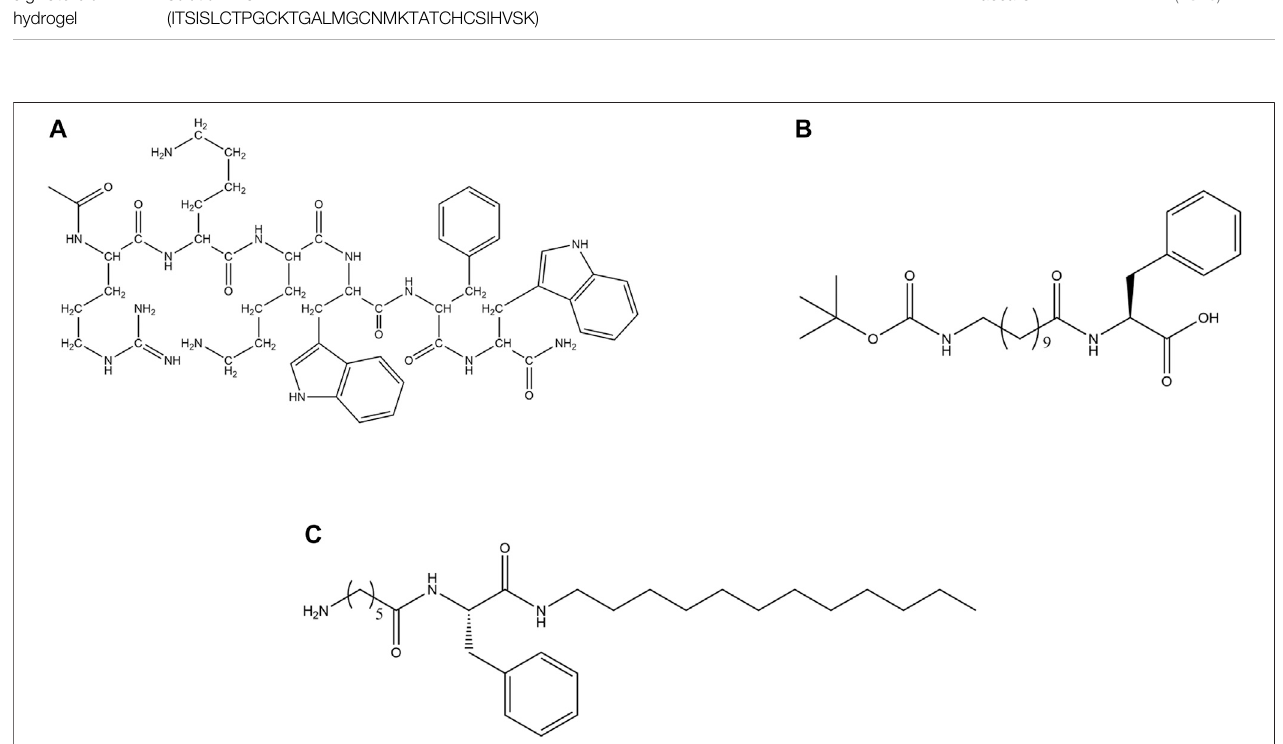
FIGURE 10 | AMPs forming hydrogels. (A) PAF26 (Cao et al., 2019). (B) Boc-AUDA-Phe-COOH (P1), (AUDA (cid:1) 11-aminoundecanoic acid) (Baral et al., 2016). (C)